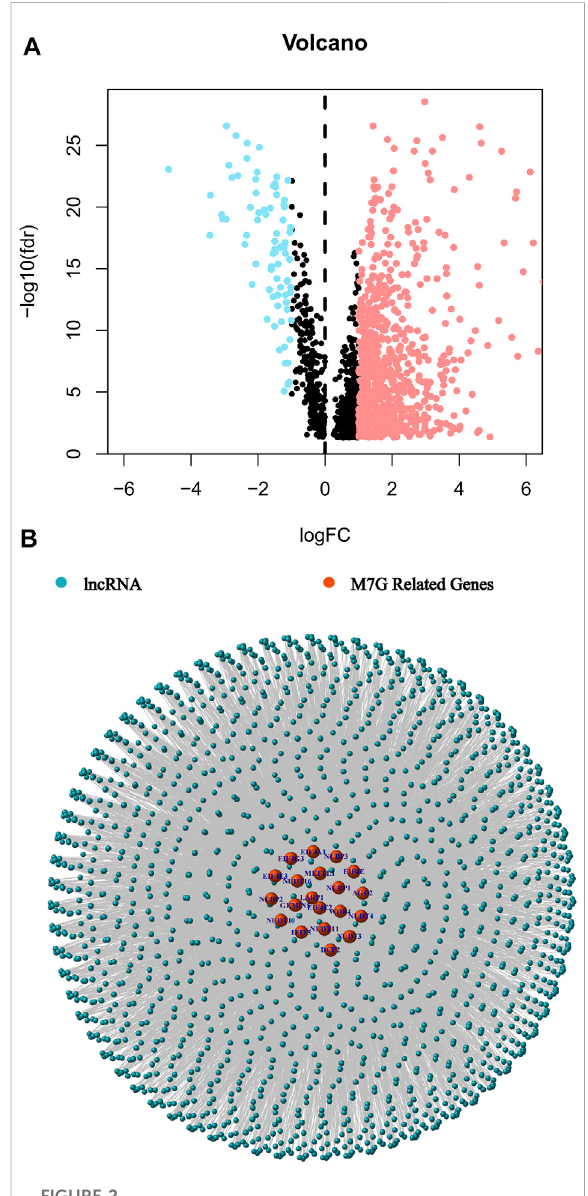
FIGURE 2 Identi fi cation of the m7G-related lncRNAs in patients with colorectal cancer. (A) The volcano plot of 827 differentially expressed m7G-related lncRNAs. (B) The network between m7G genes and lncRNAs (correlation coef fi cients > 0.4 and p <